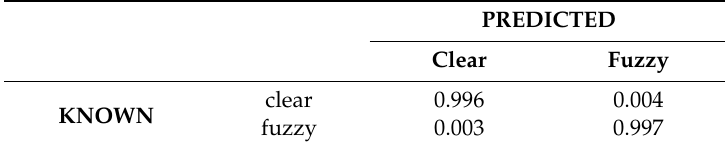
Table 7. Confusion matrix for the output of the DT classifier. Each value of the matrix represents the number of observations that are correctly and incorrectly classified.